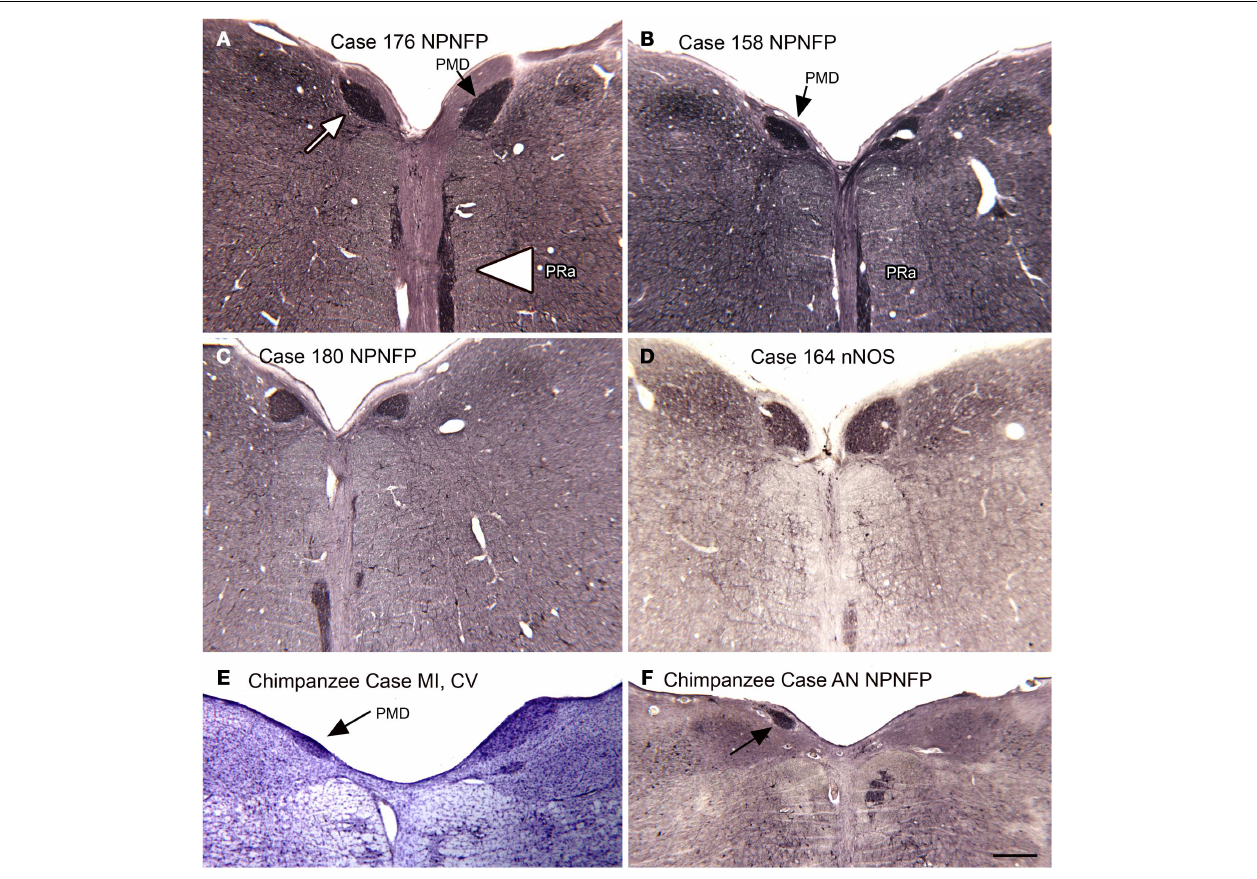
FIGURE 10 |The nucleus paramedianus (PMD) and the nucleus pararaphales (PRa) in the human and chimpanzee . (A) The arrow shows the darkly stained PMD, the arrowhead the PRa. Case 176, female, age 71. (B) Case 158, male, age 51. (C) Case 180, male, age 54. (D) Case 164, female, age 45. (E,F) PMD (arrows) in the two chimpanzees. Scale bar 500 µ m. Abbreviations, nNOS, nitric oxide synthase; NPNFP, non-phosphorylated neurofilament